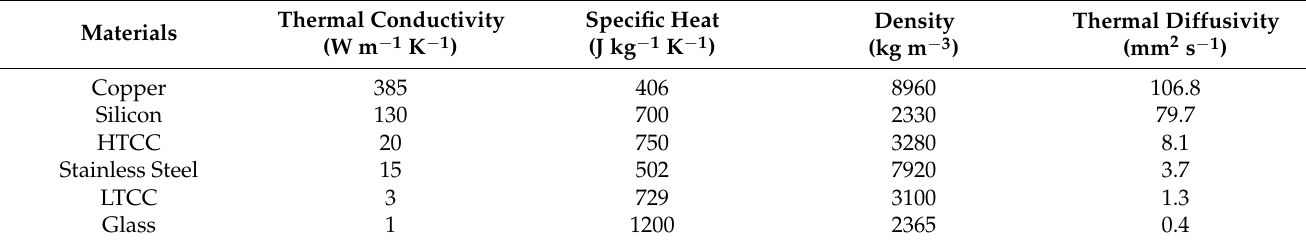
Table 3. Properties of the solid materials used in the CHT